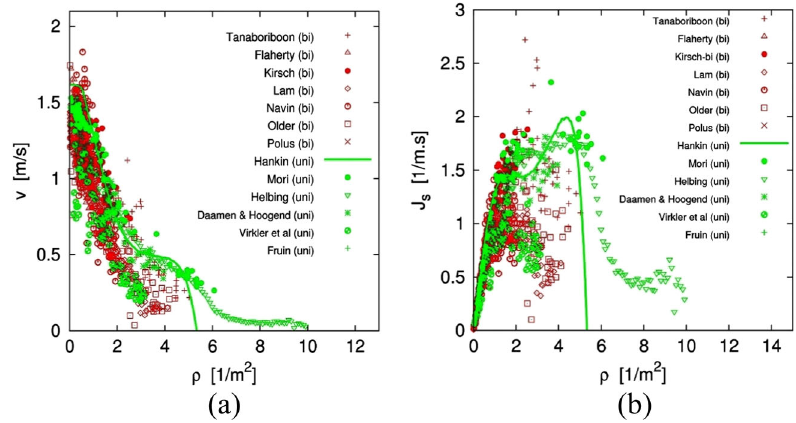
Fig. 2 Fundamental diagrams of uni and bidirectional pedestrian flow from various studies ( a ) Density – speed and ( b ) density – specific flow (Zhang and Seyfried